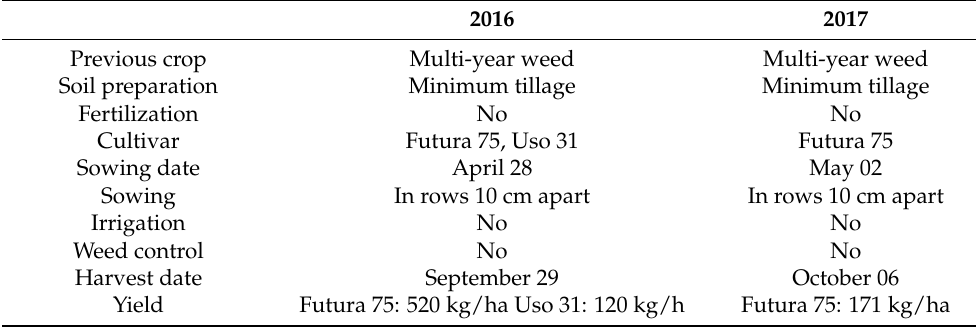
Table 1. Adopted cultivation techniques and yields.